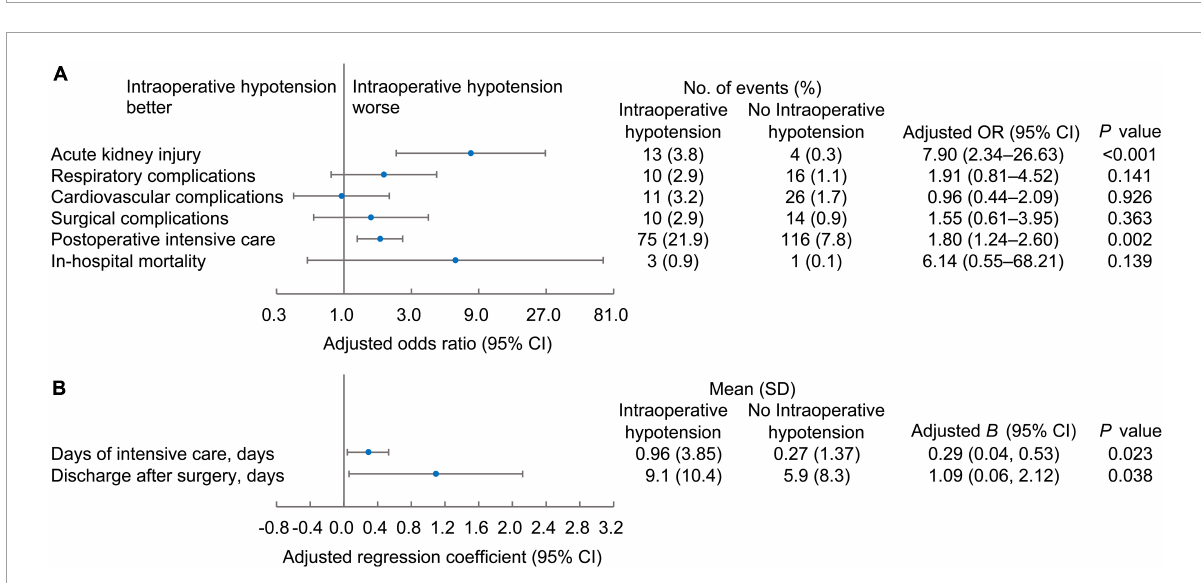
FIGURE3 The binary (A) and continuous (B) postoperative outcomes of patients according to the occurrence of intraoperative hypotension. Forest plots of the adjusted odd ratios or beta coefficient (B) values with 95% confidence intervals.